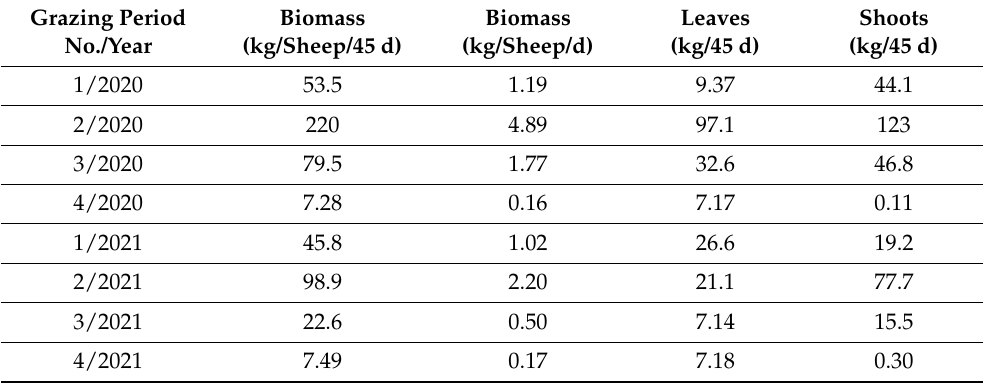
Table 1. Total ingested ragwort biomass in kg per sheep and per grazing period (45 days), also calculated as ragwort biomass in kg per sheep and day; furthermore, the amounts of ingested leaves (from rosettes and shoots) and shoots are shown in kg per 45 days (grazing period). Grazing